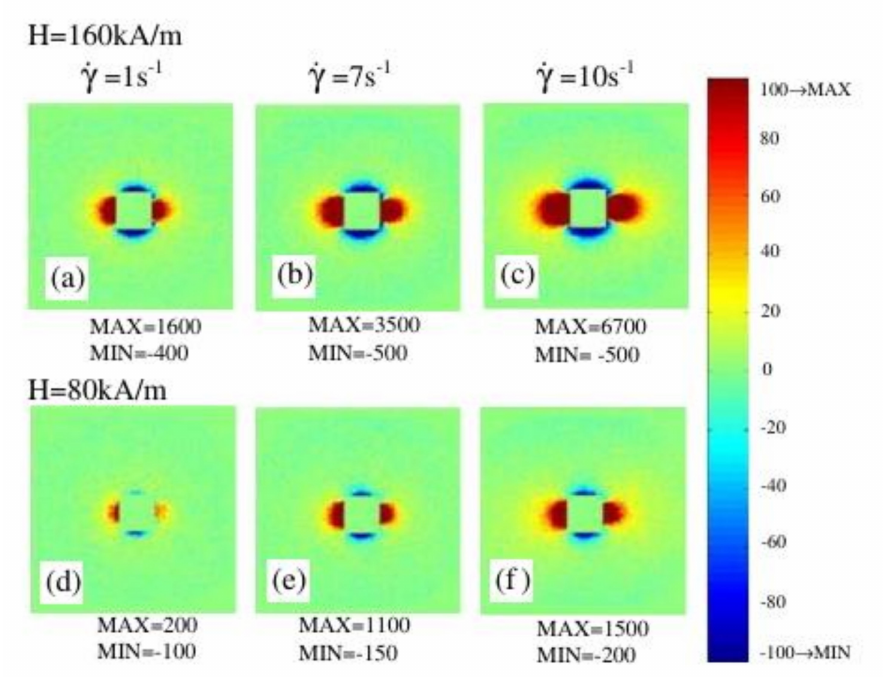
Figure 4. ( a – f ) Patterns obtained using small-angle neutron scattering for a ferrofluid based on cobalt nanoparticles for di ff erent magnetic field strengths and shear rates. The image was sourced from [77], copyright Elsevier.